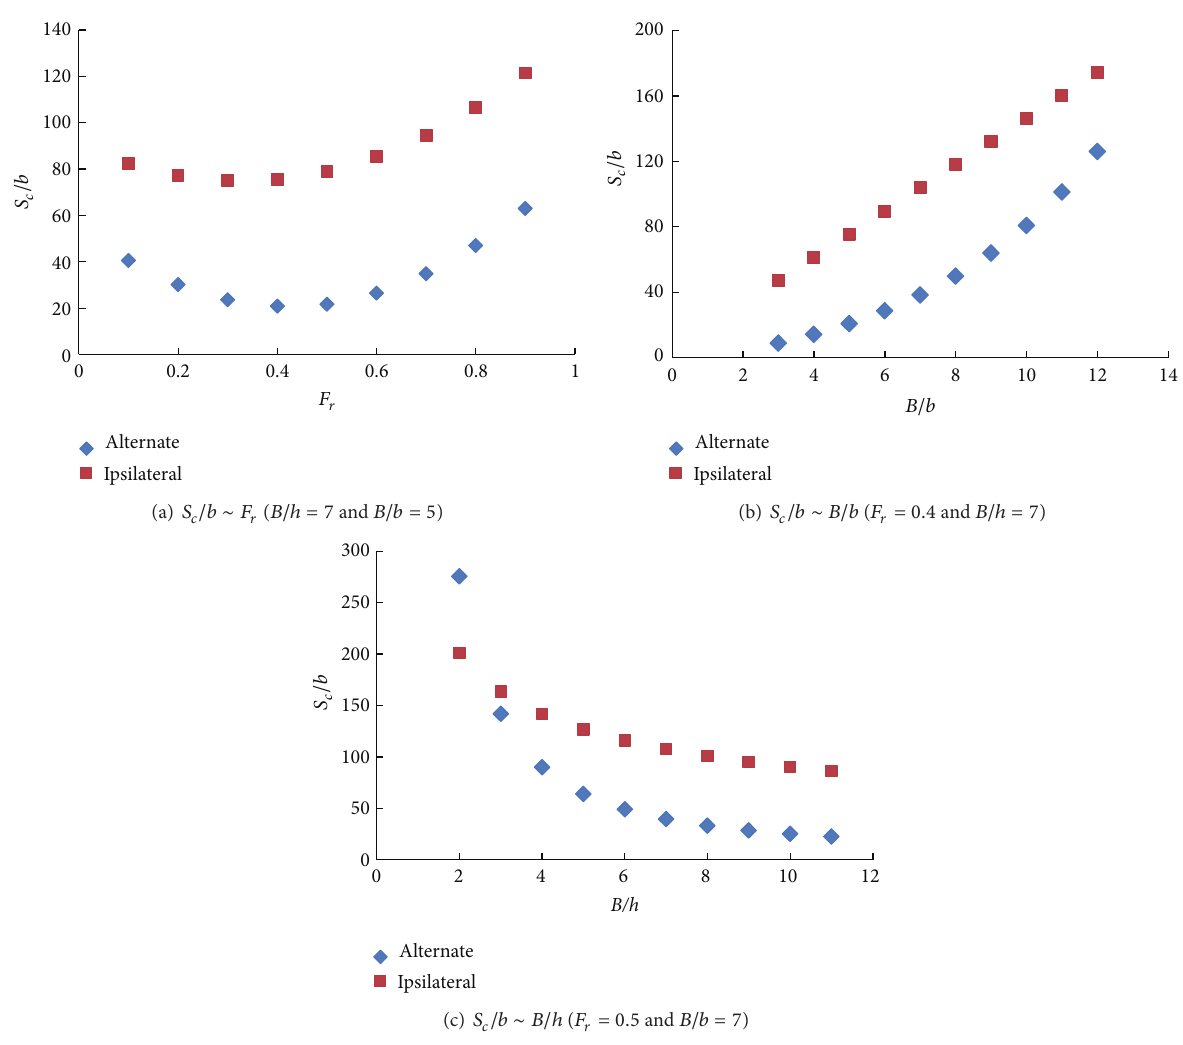
Figure 6: Comparison of empirical formulas between alternate spur dikes and ipsilateral spur